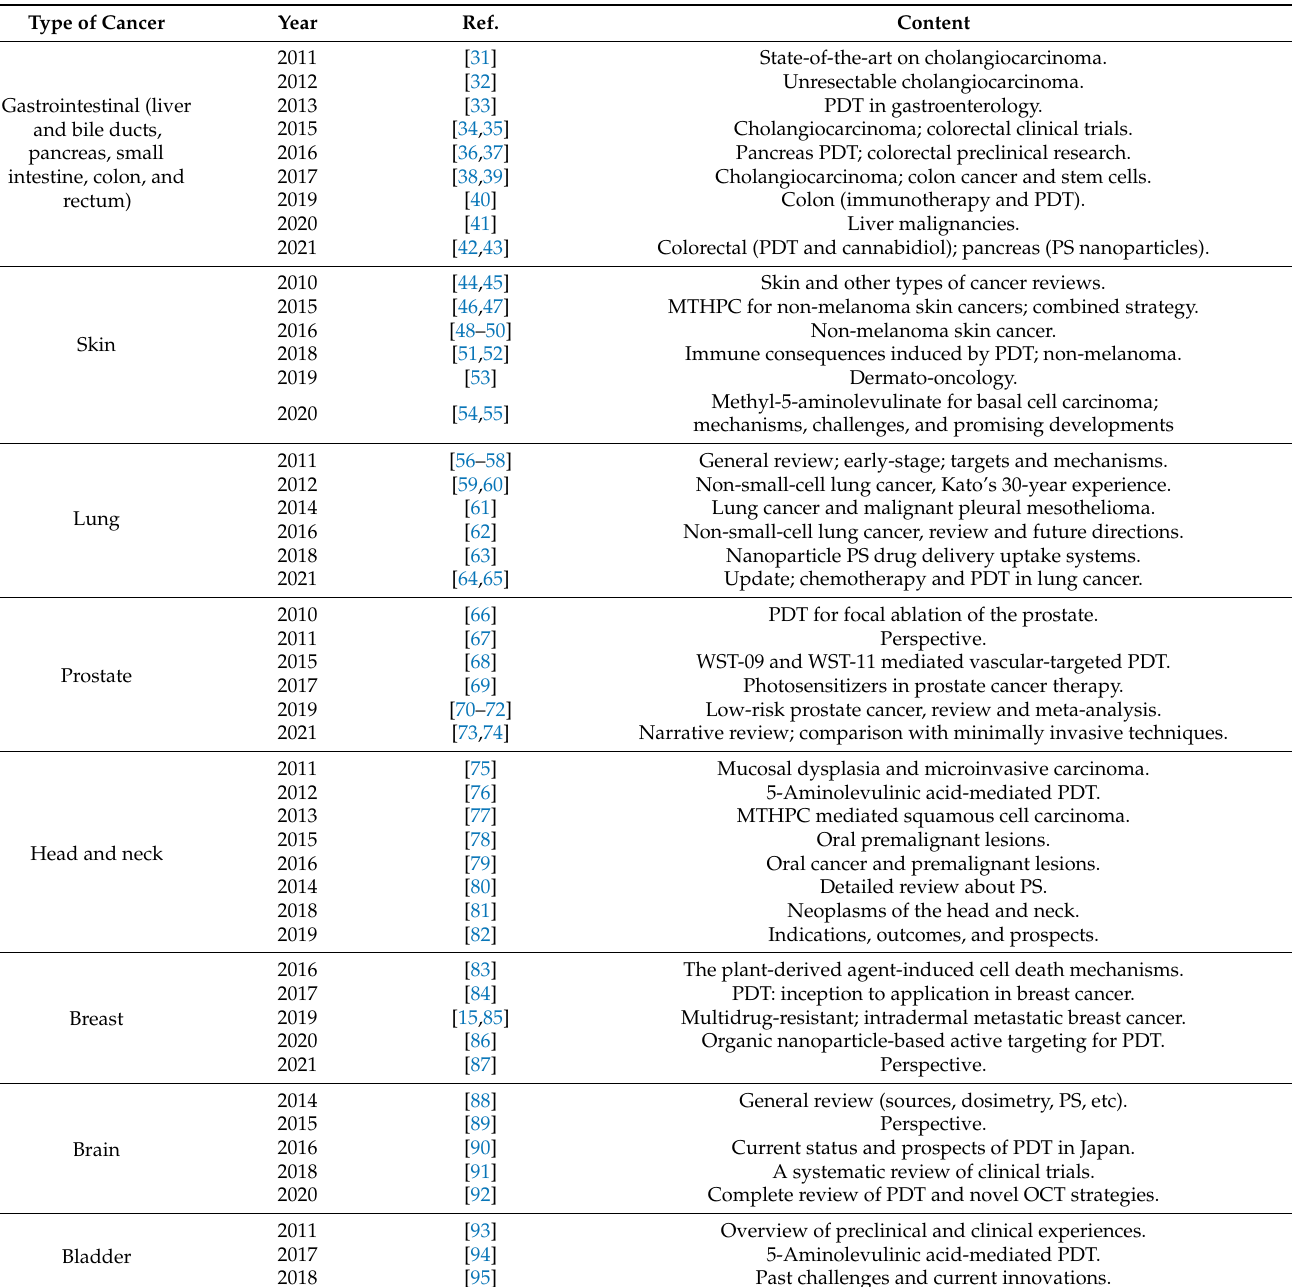
Table 1. Reviews of the last decade for the most studied types of cancers in the PDT